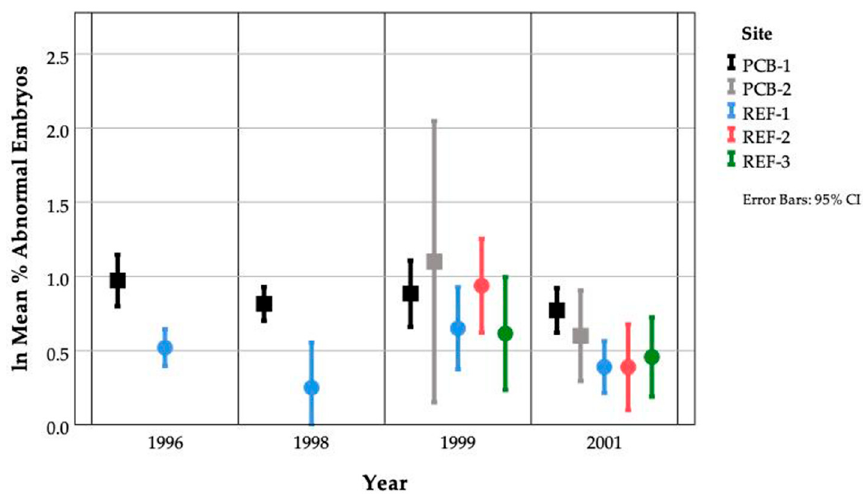
Figure 4. PCB concentrations in fish from Johnston Atoll from three sampling years. Note that these are natural log-transformed data.